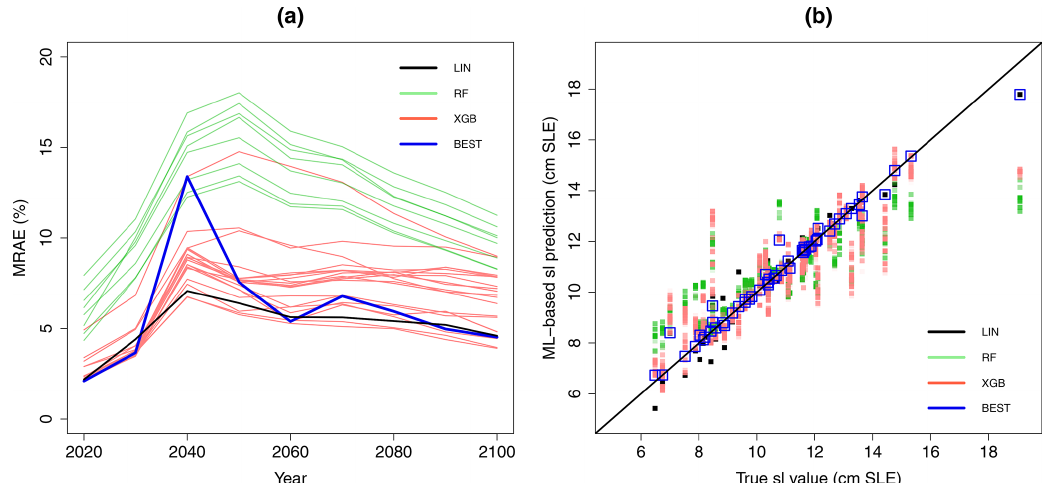
Figure 5. (a) Time evolution of the performance criterion MRAE (expressed in %) computed using a leave-one-out cross-validation procedure that assesses the predictive capability of all considered ML models with different parametrisations (RF models in green, XGB in red, and LIN in black). The blue-coloured lines are related to the performance criterion after selecting the best-performing ML model with respect to the joint minimisation of the global and of the local performance indicator described in Sect. 3.2; (b) comparison between the true and the ML-based predicted sl value for 2100 by considering all ML models. The blue-coloured squares outline the retained results after selecting the best-performing ML